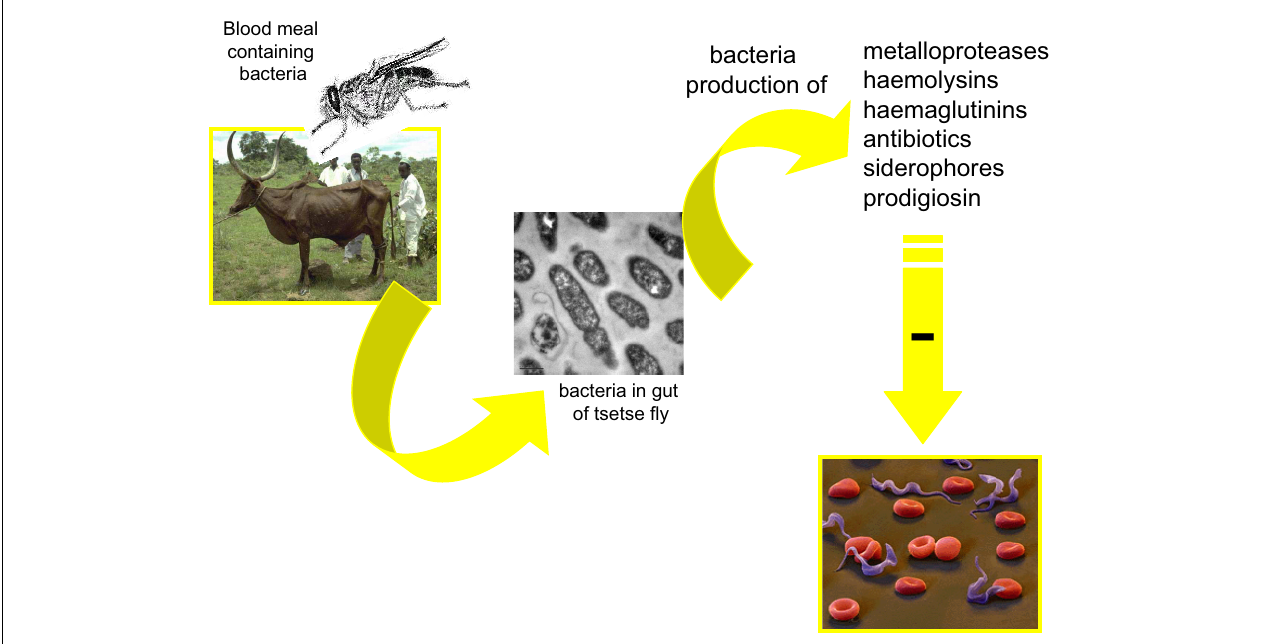
FIGURE 4 | Possible mechanism involved in the modulation, by the midgut microbiota, of the tsetse fly infection by trypanosomes.